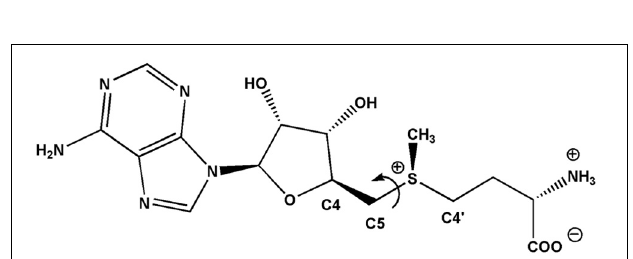
FIGURE 3 | Conformation of SPDS-bound dcSAM will change in SAM by a rotation around the bond S + − C5.